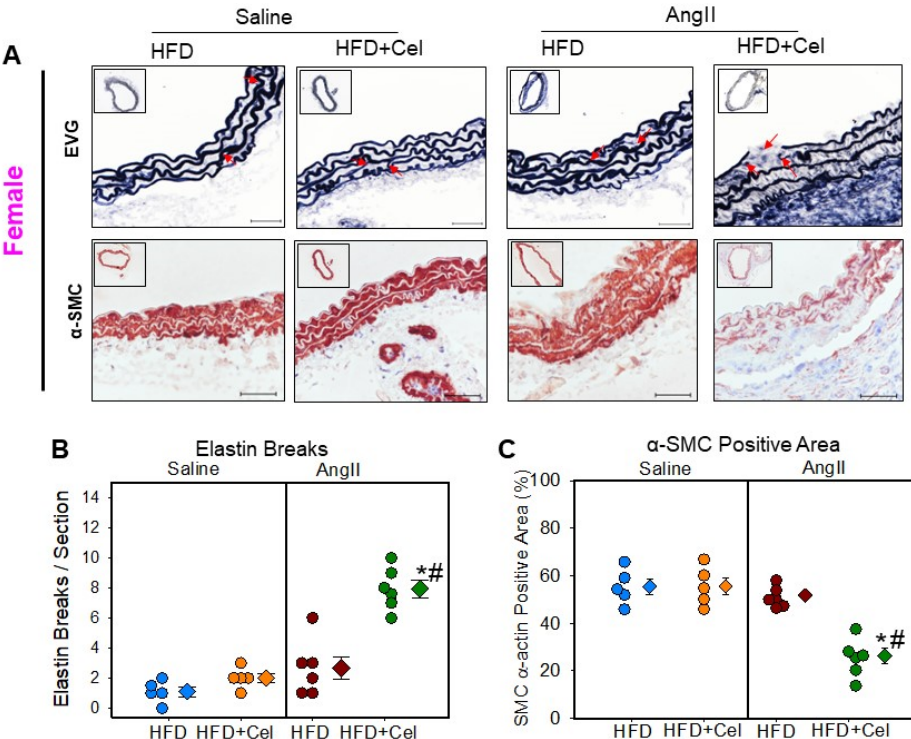
Figure 5. ( A ) Representative suprarenal aortic tissue sections from saline or Ang II (1000 ng/kg/min)